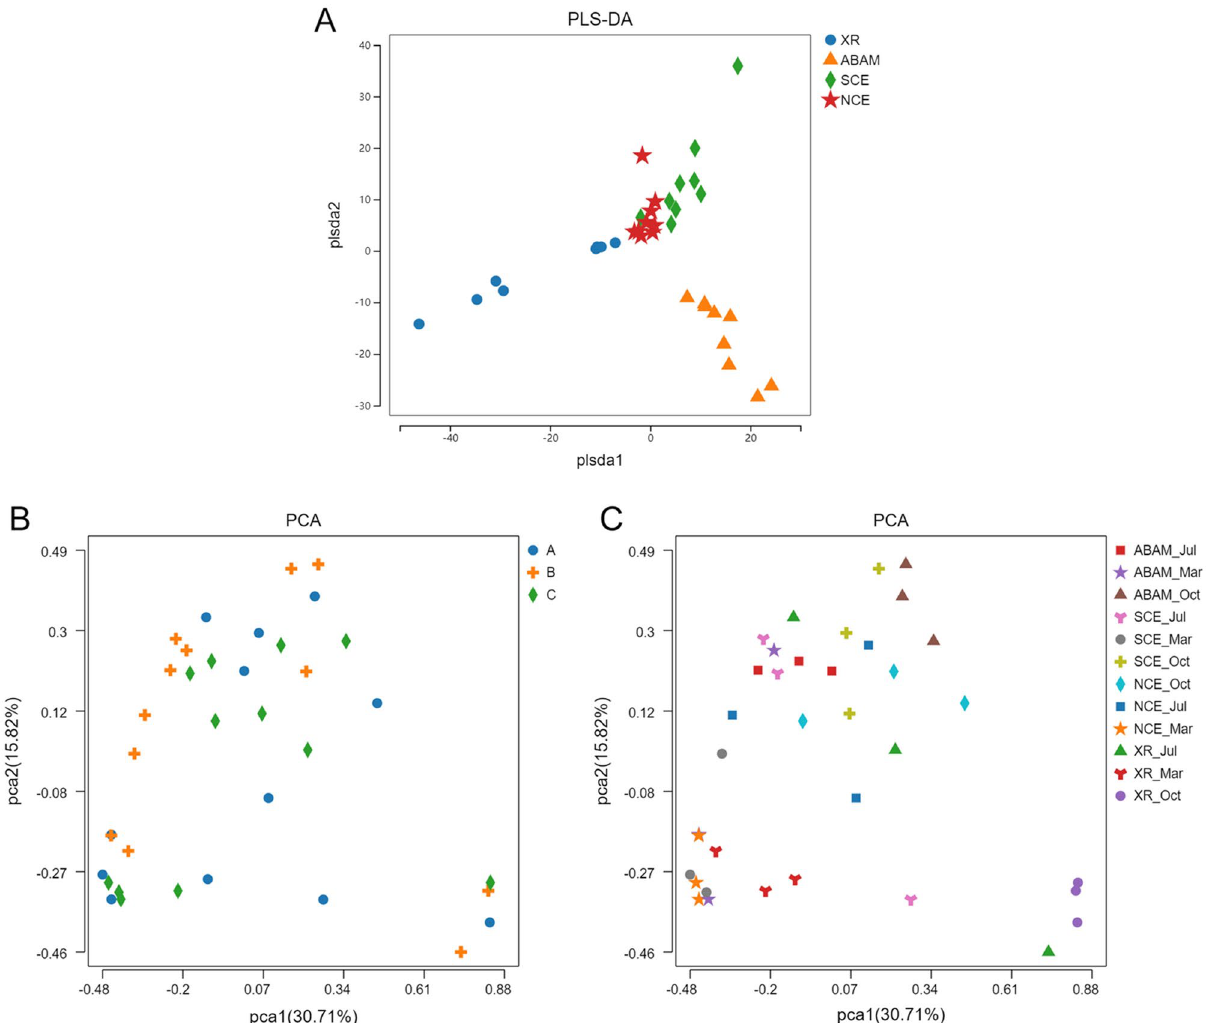
Figure 4. ( A ) Partial least squares Discriminant Analysis (PLS-DA) plots of microbial communities of the three treatments plus the natural reef from the three localities over the three seasons, based on Bray–Curits distances. ( B , C ) Principal Component Analysis (PCA) of the different treatments based on ASVs and species